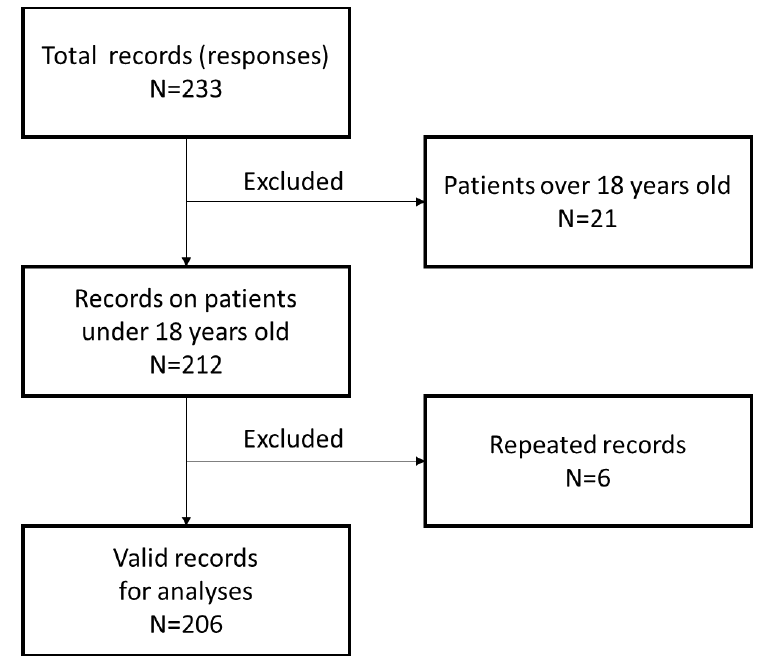
Figure 1. Flow chart of data collection.